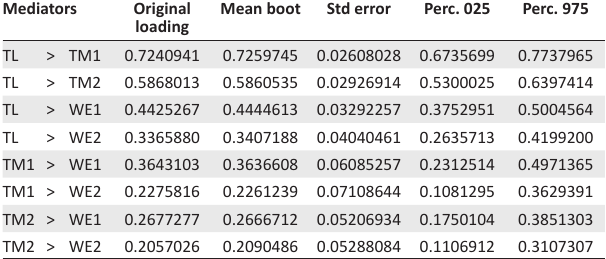
TABLE 3 : Total effect estimation of parameters and associated standard errors.